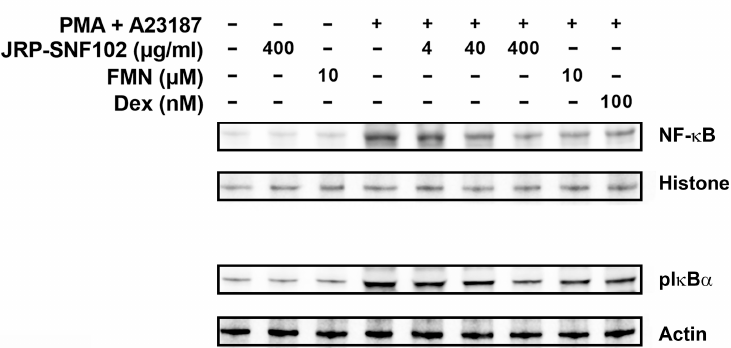
Figure 4. An inhibitory effect of JRP-SNF102 or FMN on NF- κ B expression. HMC-1 cells were incu- bated with or without JRP-SNF102, FMN, or Dex for 1 h, followed by PMA and A23187 stimulating for 2 h. NF- κ B level in nucleus and pIkB α level in cytoplasm were determined by Western blotting. − , non-treatment; +, treatment.